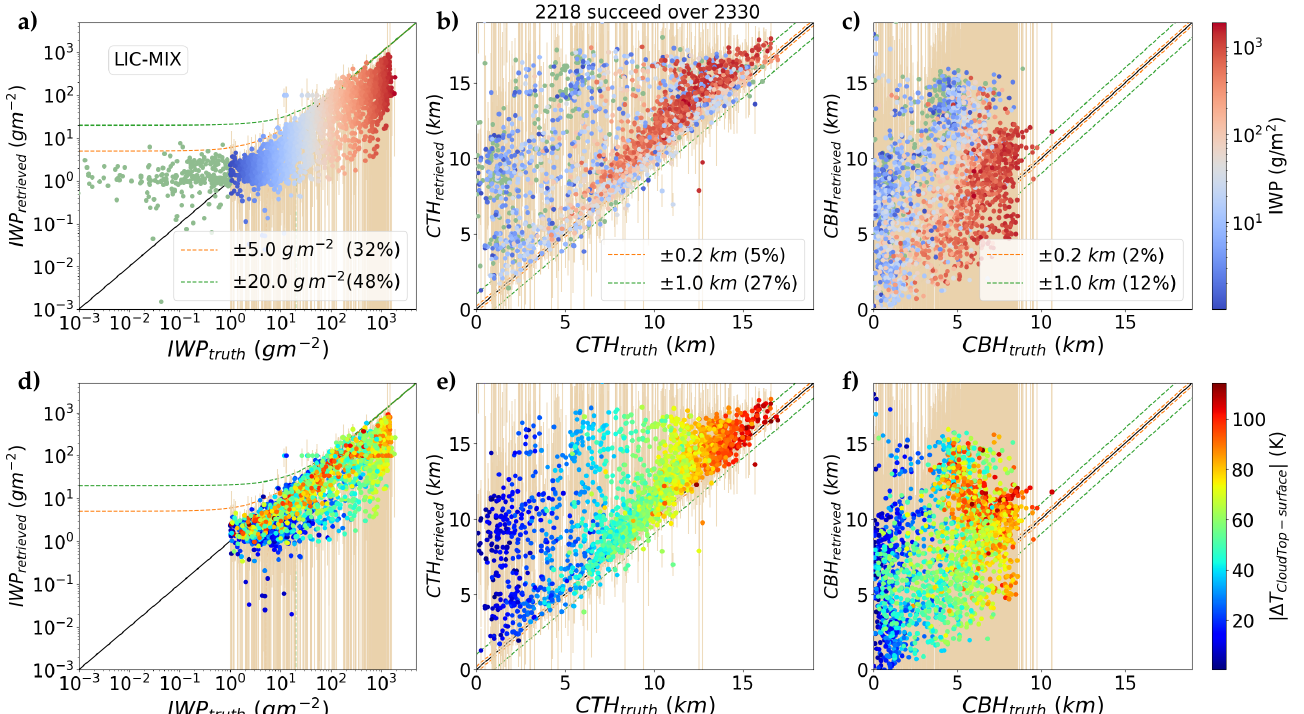
Figure 9. Same as Figure 7 but for LIC-MIX cloud